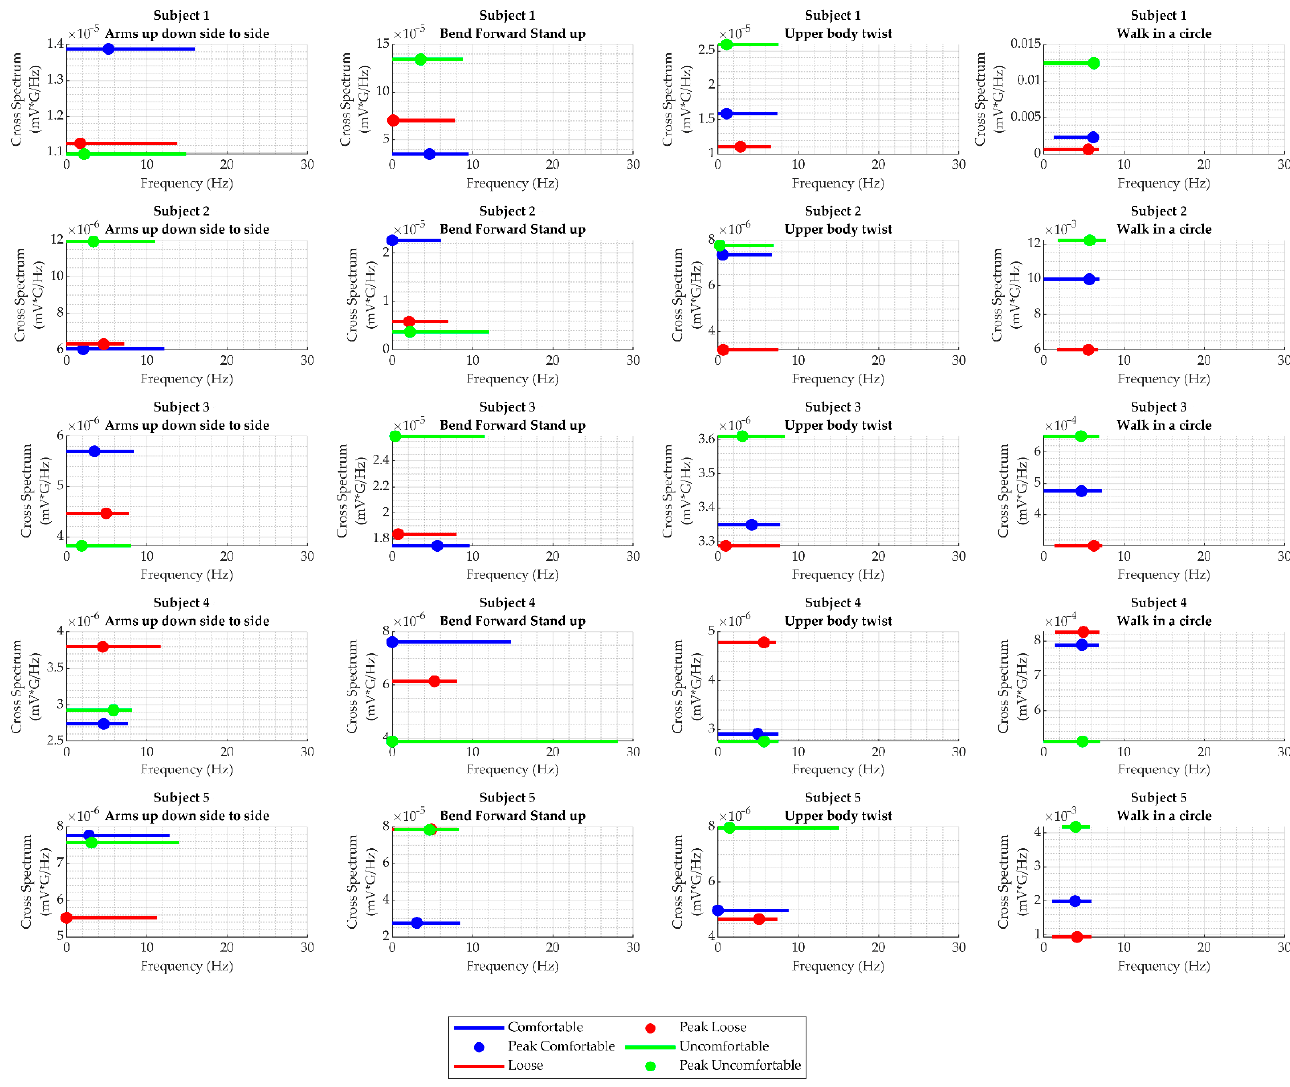
Figure 14. Cross-Spectral Coherence between activity and heart sounds measured by WPAS.